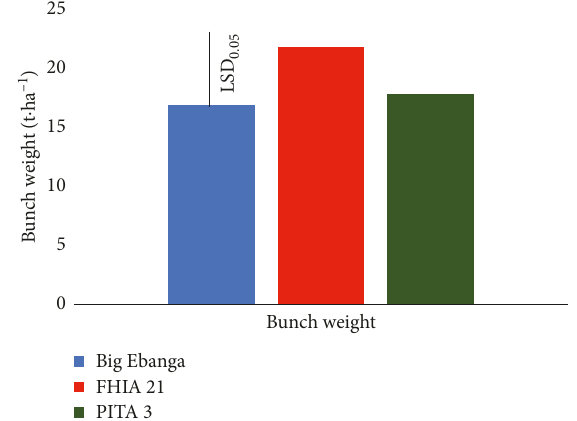
1 ) of medium-sized tetraploid Figure 6: Bunch harvest (t ha · plantain hybrids FHIA 21 and PITA 3 along with giant false horn − plantain “Big Ebanga” at advanced yield trial using 3 replications at a plant density of 3 m 2m in Benin. The average yield of plantain × on family farms in this country remains very low: from 4 to 7t